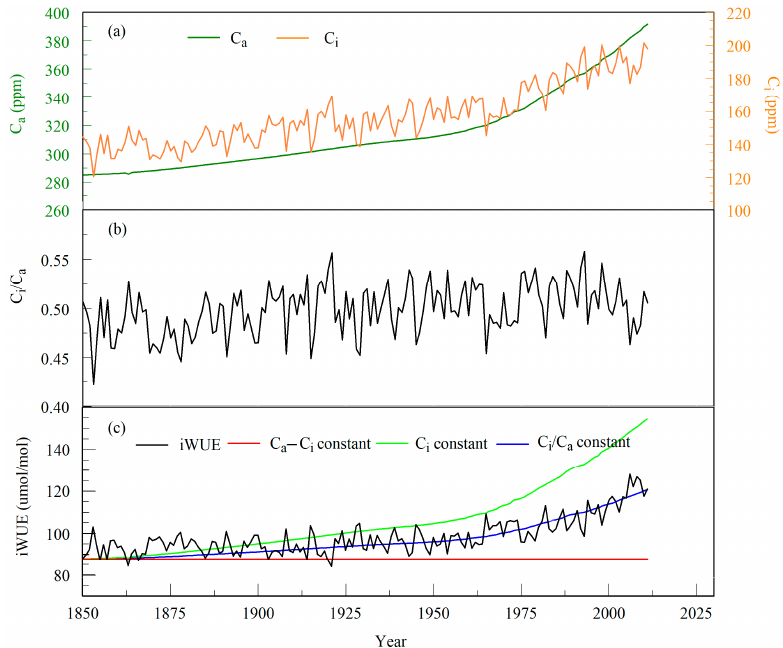
Figure 4. ( a ) Variations in atmospheric CO 2 concentration (C a ) and leaf intercellular CO 2 concentra- tion (C i ), ( b ) 13 C discrimination ratios (C i /C a ), and ( c ) iWUE calculated from three scenarios as a baseline for interpreting gas exchange in response to increasing C a [53]. The atmospheric CO 2 concentration was derived from McCarroll and Loader